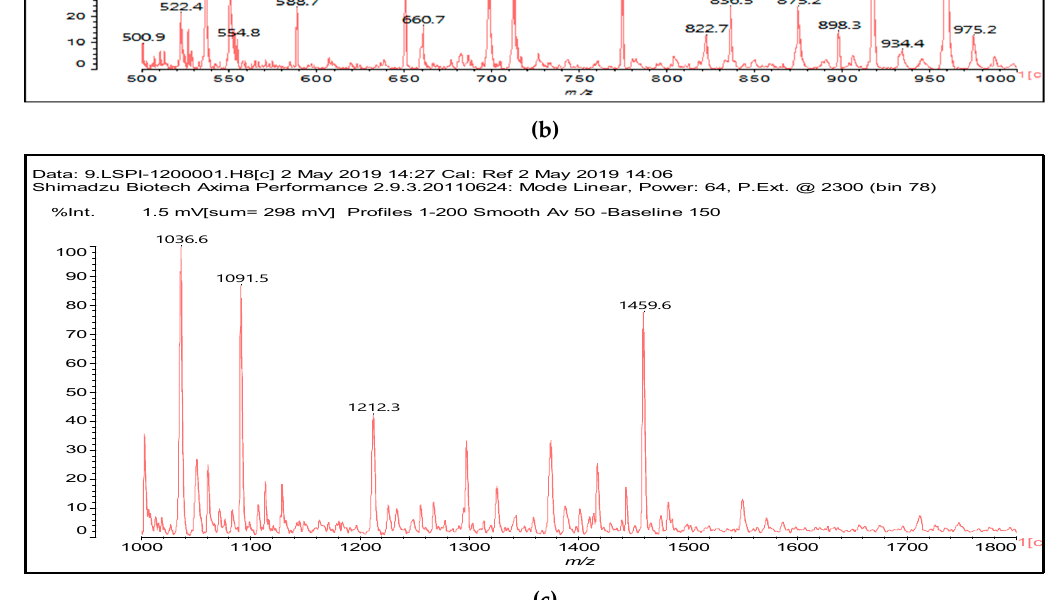
Figure 2. The MALDI ToF spectra of the soy protein isolate after a treatment with sodium periodate at 120 °C for 1 hour. ( a ) 100 Da to 500 Da range. ( b ) 500 Da to 1000 Da range. ( c ) 1000 Da to 1500 Da range.